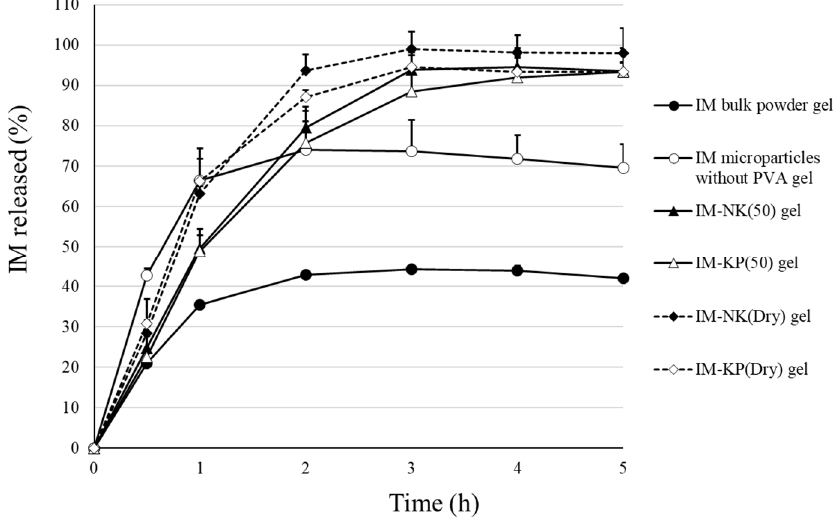
Figure 10. Drug Release Profiles from the Gel Preparations. Each Point Represents the Mean ± SD ( n = 3).